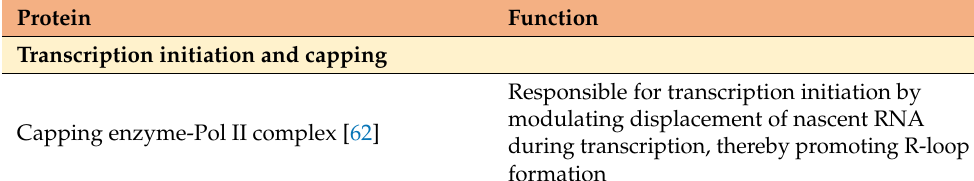
Table 1. Identity and function of R-loop-binding and R-loop-regulating